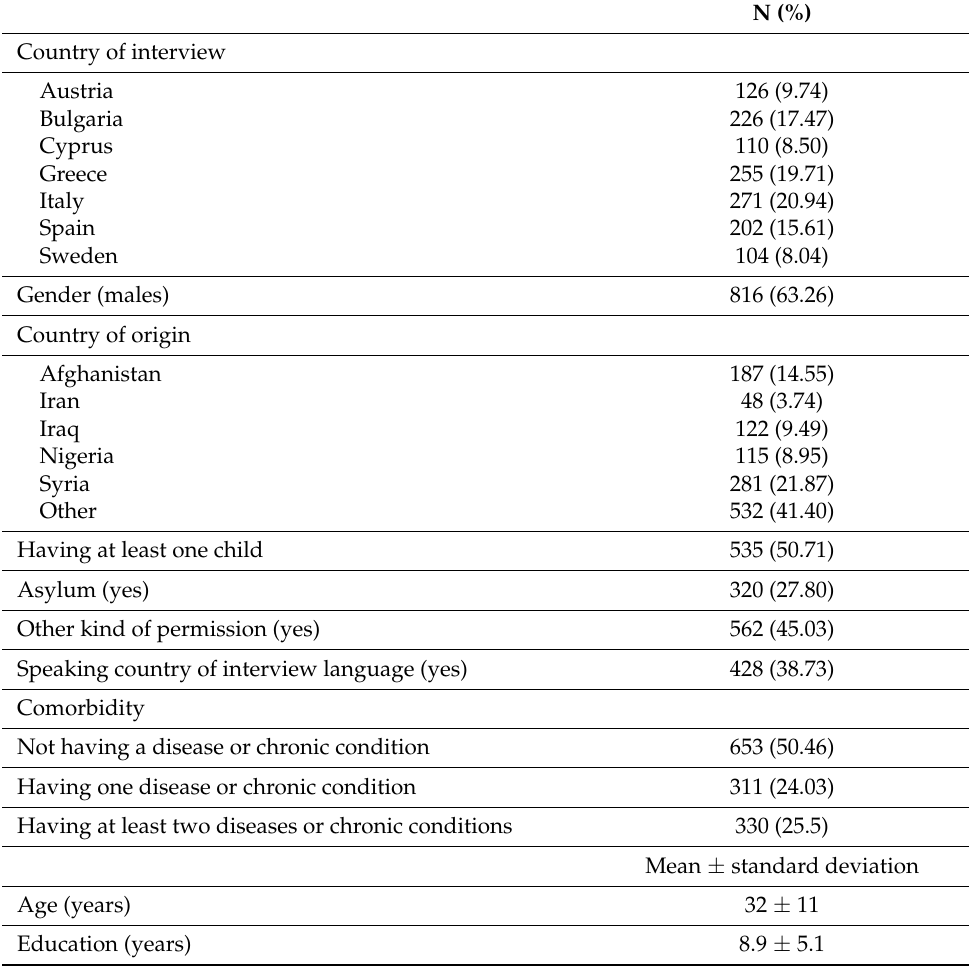
Table 1. Characteristics of migrants and refugees, except those from Germany, France, and Malta (N =